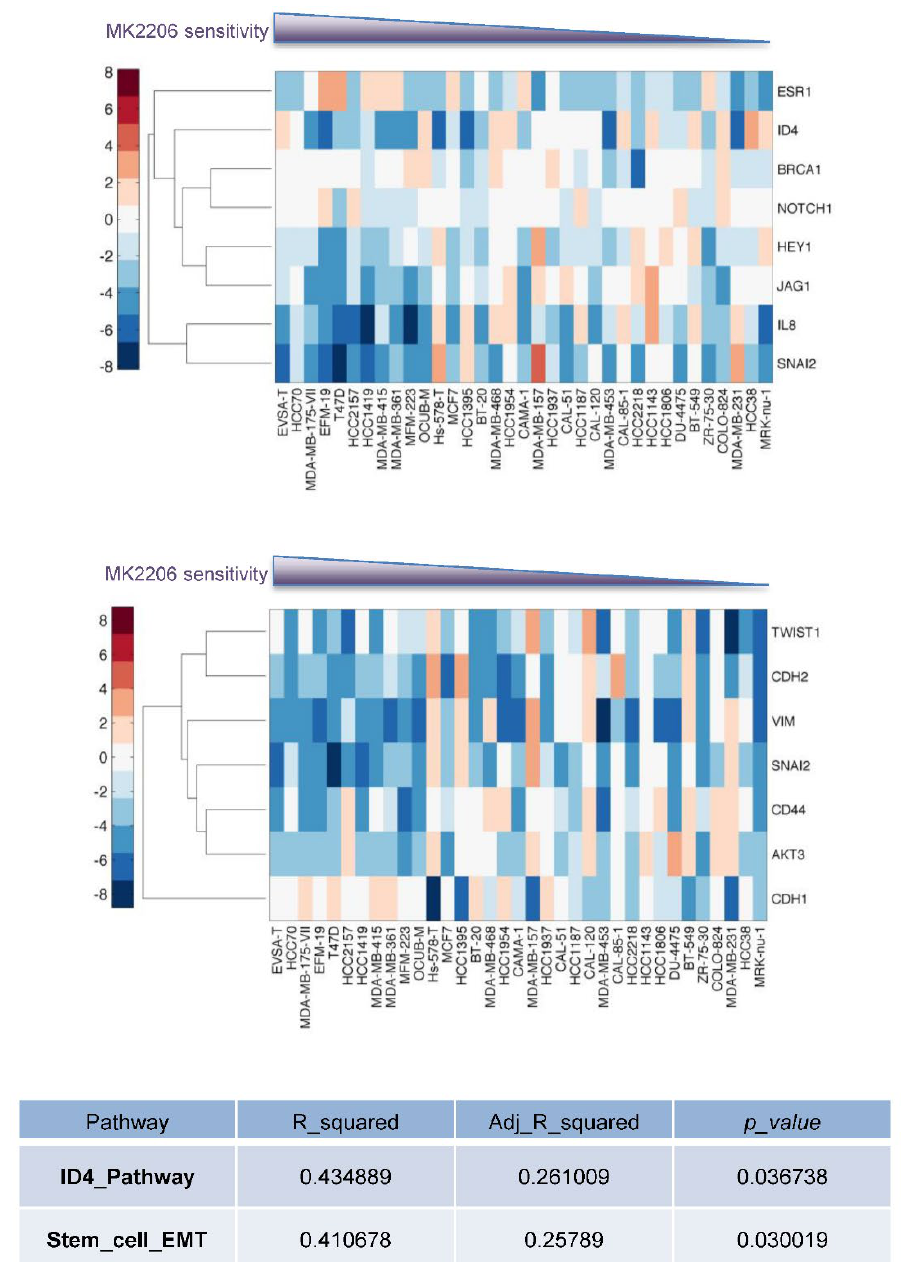
Figure 5. Genes in ID4 and stem cell/EMT pathways predict sensitivity to MK2206. Upper panel: Heatmap of pathway analysis showing relative expression of various genes in ID4 pathway in different breast tumor lines. Tumor lines are arranged based on MK2206 sensitivity. The cell line on the left (EVSA-T) is the most sensitive to MK2206. Lower panel: Heatmap showing relative expression of various genes in stem cell/EMT pathway. Table: Using cosmic analysis with multiple regression method, the data indicate that the expression values of each gene within the set (ID4, stem cell/EMT) are able to predict the MK2206 sensitivity for each cell line